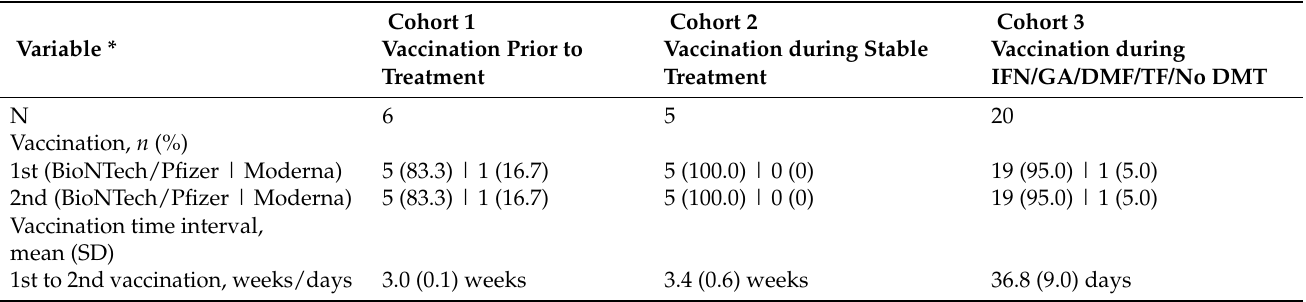
Table 2. Vaccination